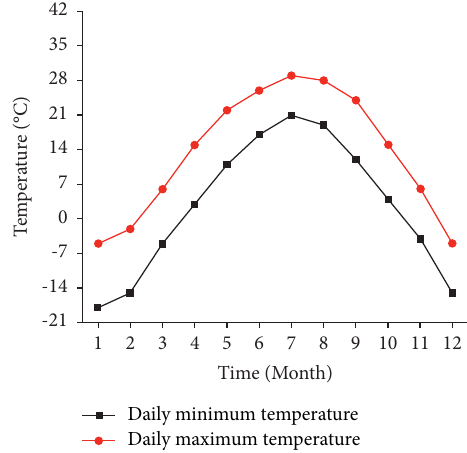
Figure 2: Annual temperature curve of Shenyang